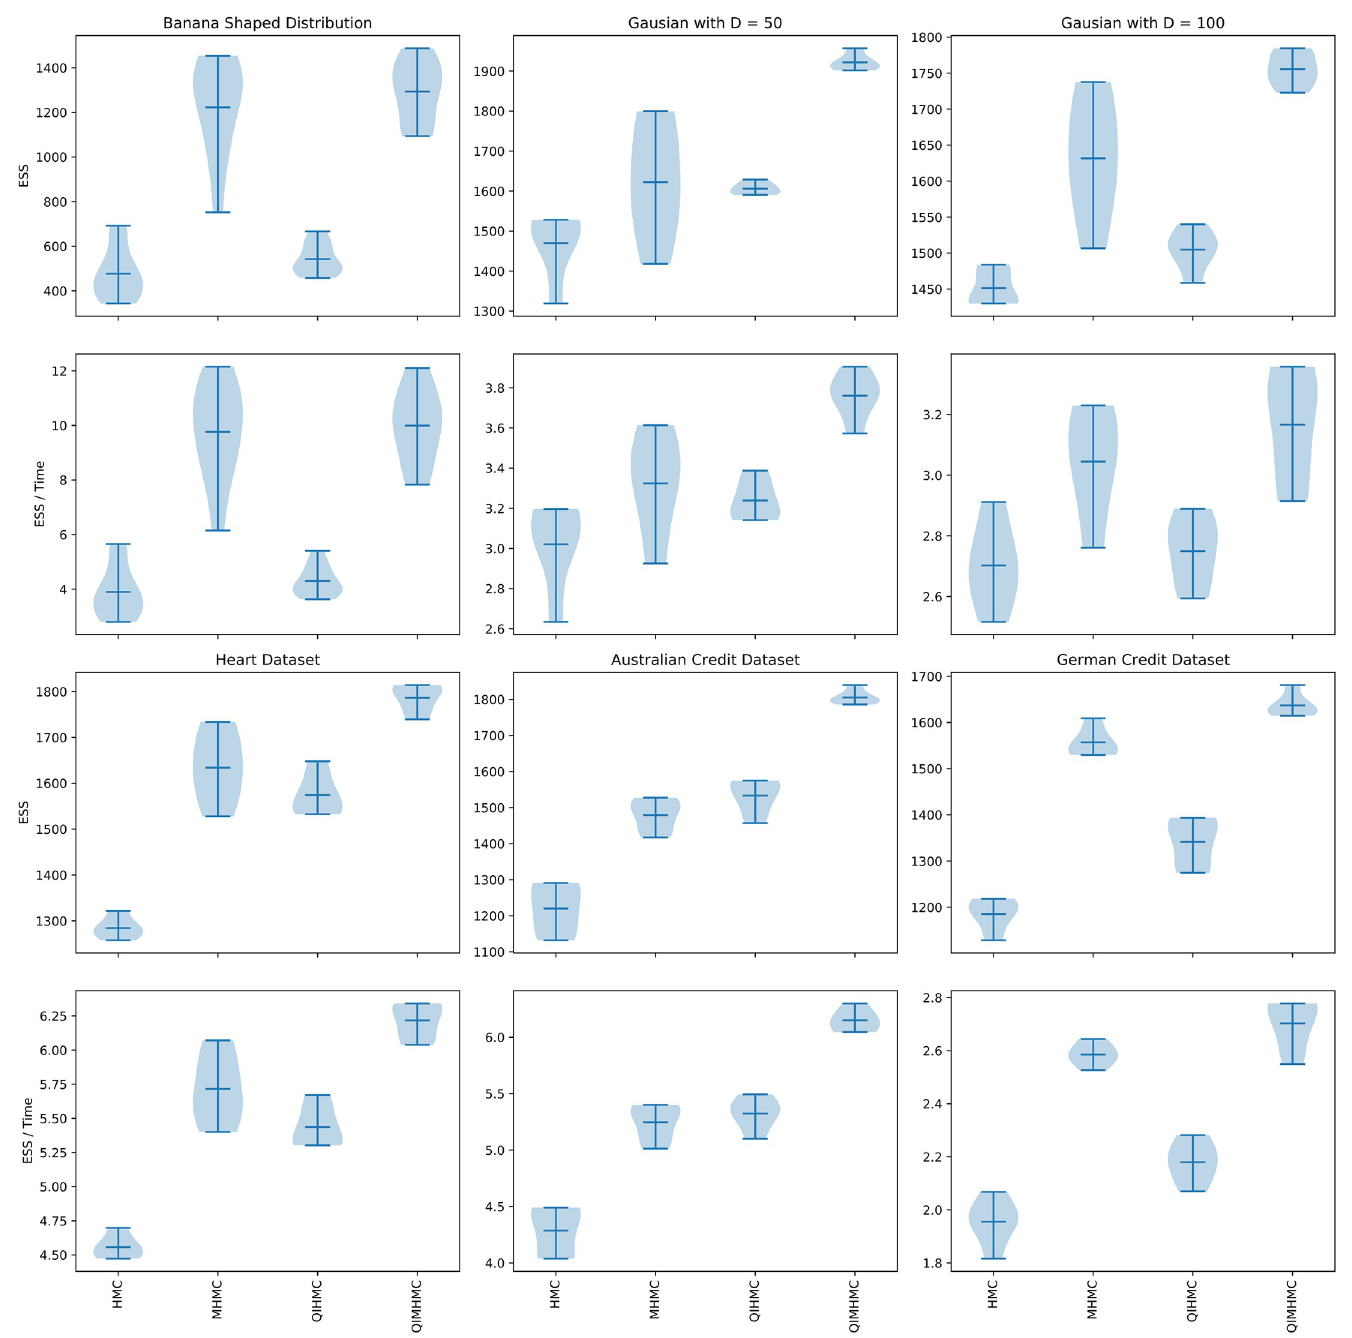
Fig 2. Results for the datasets over 10 runs of each method. For each dataset, the plots on the first row show the multivariate effective sample size and the plots on the second row show the multivariate effective sample size normalised by execution time (in seconds). For all the plots, the larger the value the better the method. The dark horizontal line in each violin plot represents the mean value over 10 runs of each